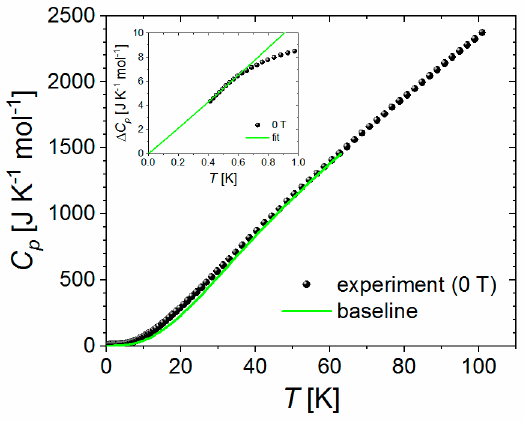
Figure 3. Heat capacity of 1 (symbols) together with the baseline (solid line). Inset: Zero-field excess heat capacity in the low temperature range (symbols) with the algebraic fit f T µ (solid line).